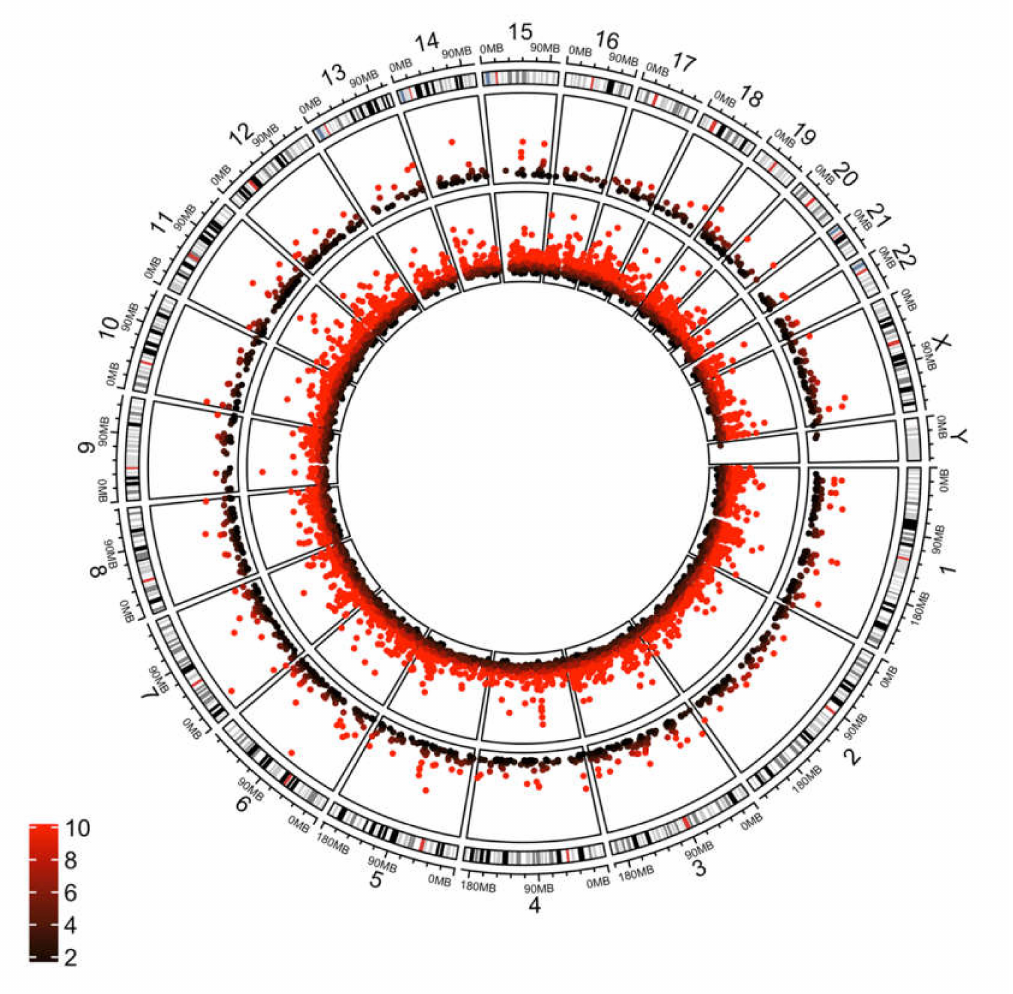
Figure 3. Circos plot showing di ff erentially expressed host genes (inner ring) and HERVs (outer ring) across chromosomal locations. Values are plotted on a − log (adjusted p -value) scale. Color indicates degree of significance, with the darkest colors corresponding to lowest significant p -value (0.05), with the brightest red corresponding to an adjusted p -value of p < 0.00000000001. Plot was generated using circlize in R